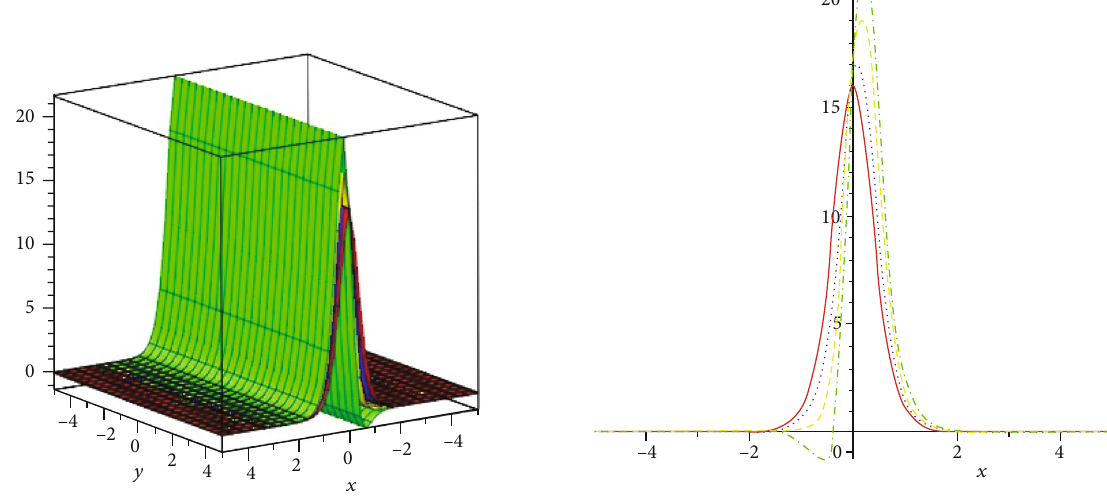
Figure 7: Graphical view of analytical solution at various values of δ for K ð ζ , ρ Þ of system 1